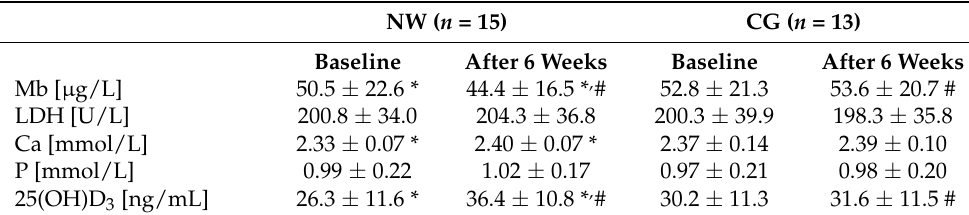
Table 2. Changes in average concentrations of biochemical indices in multiple myeloma patients after a cycle of 6-weeks of Nordic walking